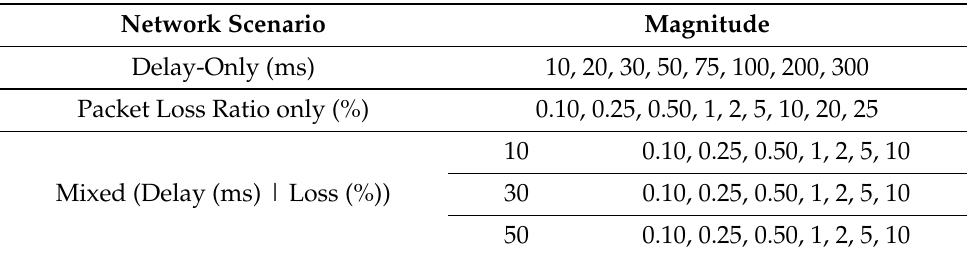
Figure 3. Block diagram of processes taking place on the client and server side and the flow of traffic. Table 1. Summary of network